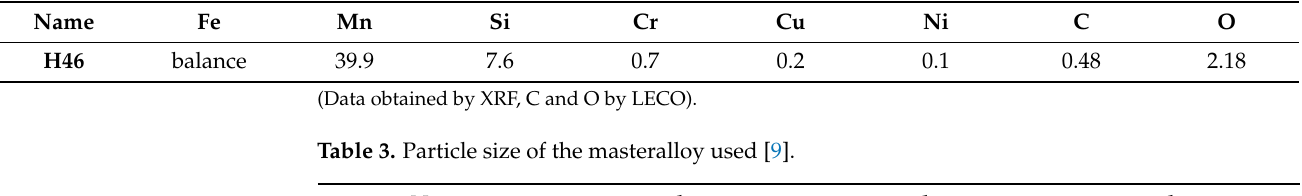
Table 2. Chemical composition of the masteralloy used (wt.%).